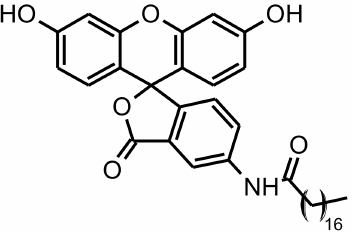
Figure 1. ODAF structure (lactone